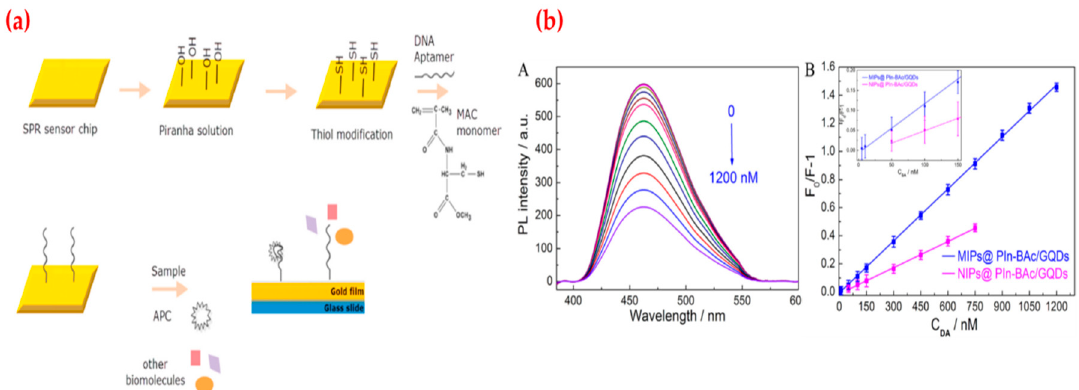
Figure 3. ( a ) Scheme of SPR sensor for human protein A detection and ( b ) fluorescence emission spectra with different dopamine concentration (A), the calibration curve (B). Republished with permission from [105,107]; permission conveyed through the Copyright Clearance Center, Inc.